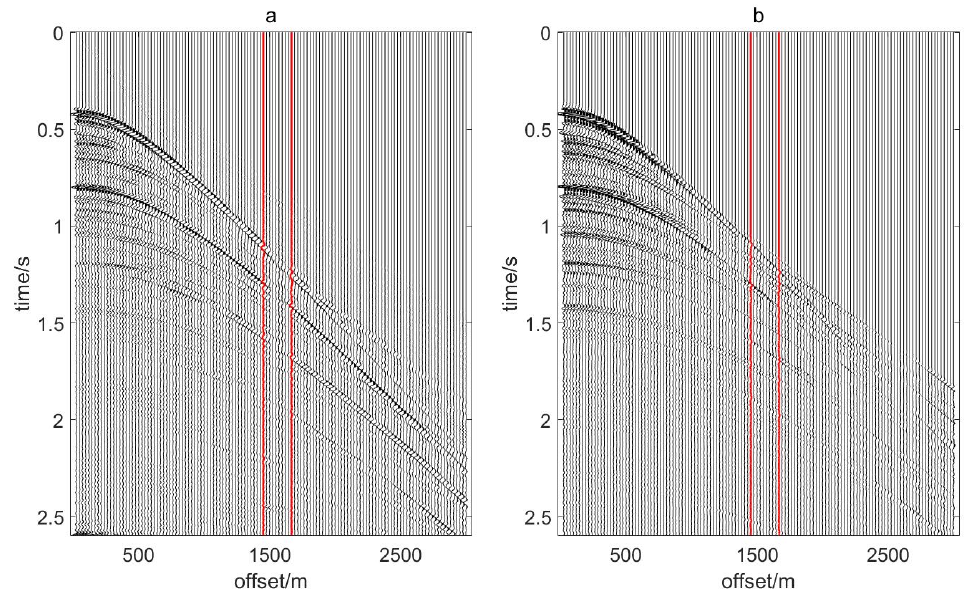
Figure 11. ( a ) CGRT inverse transform result; ( b ) WRT inverse transform result. Figure 12 shows the waveform of the original data and the inversion results at trace 10 and trace 64 at the reconstruction region. The black line represents the original data, while the red line and the blue line represent CGRT and WRT, respectively. Compared with the CGRT, for the field data, the WRT kept the waveform more accurate and pre- served the AVO. The SNR of the reconstructed results for the CGRT and for the WRT are 4.32 dB and 9.71 dB, respectively.